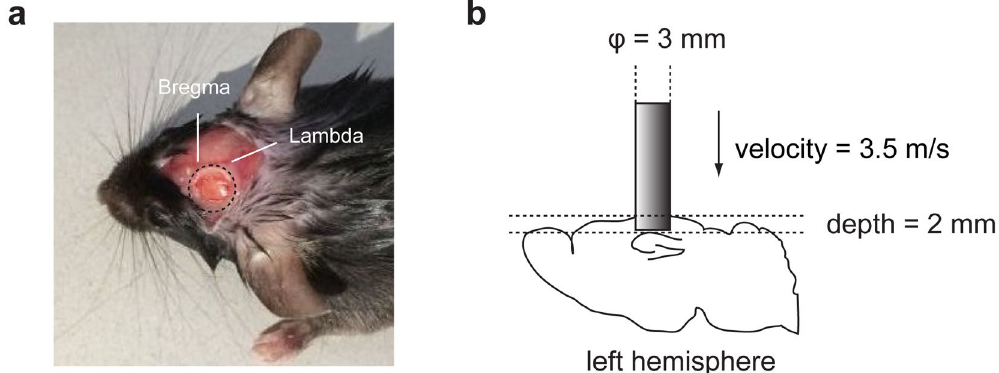
Figure 6. Moderate controlled cortical impact mouse model. ( a ) The left skull was exposed and subjected to a 4-mm-diameter craniotomy using a motorized drill. Dura was intact. The craniotomy position was located in the centre of left parietal bone between bregma and the lambdoid suture. ( b ) The controlled cortical impact was performed using a 3-mm-diameter metal tip with a parameter of 2 mm below the dura, 3.5 m/s impact speed and 100 msec dwell